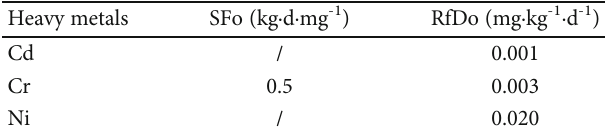
Table 3: The cancer slope factor (SFo) and reference dose (RfDo) of heavy metals via drinking water from the study area (/ indicates that no relevant data has been